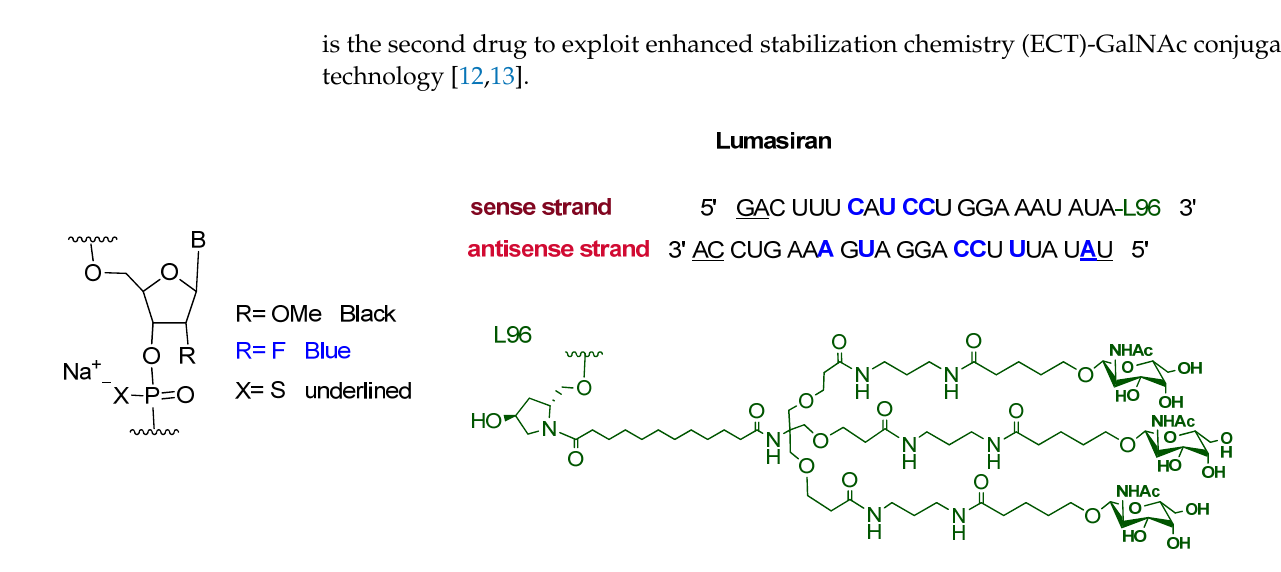
Figure 3. Chemical structure of lumasiran (Oxlumo TM ).